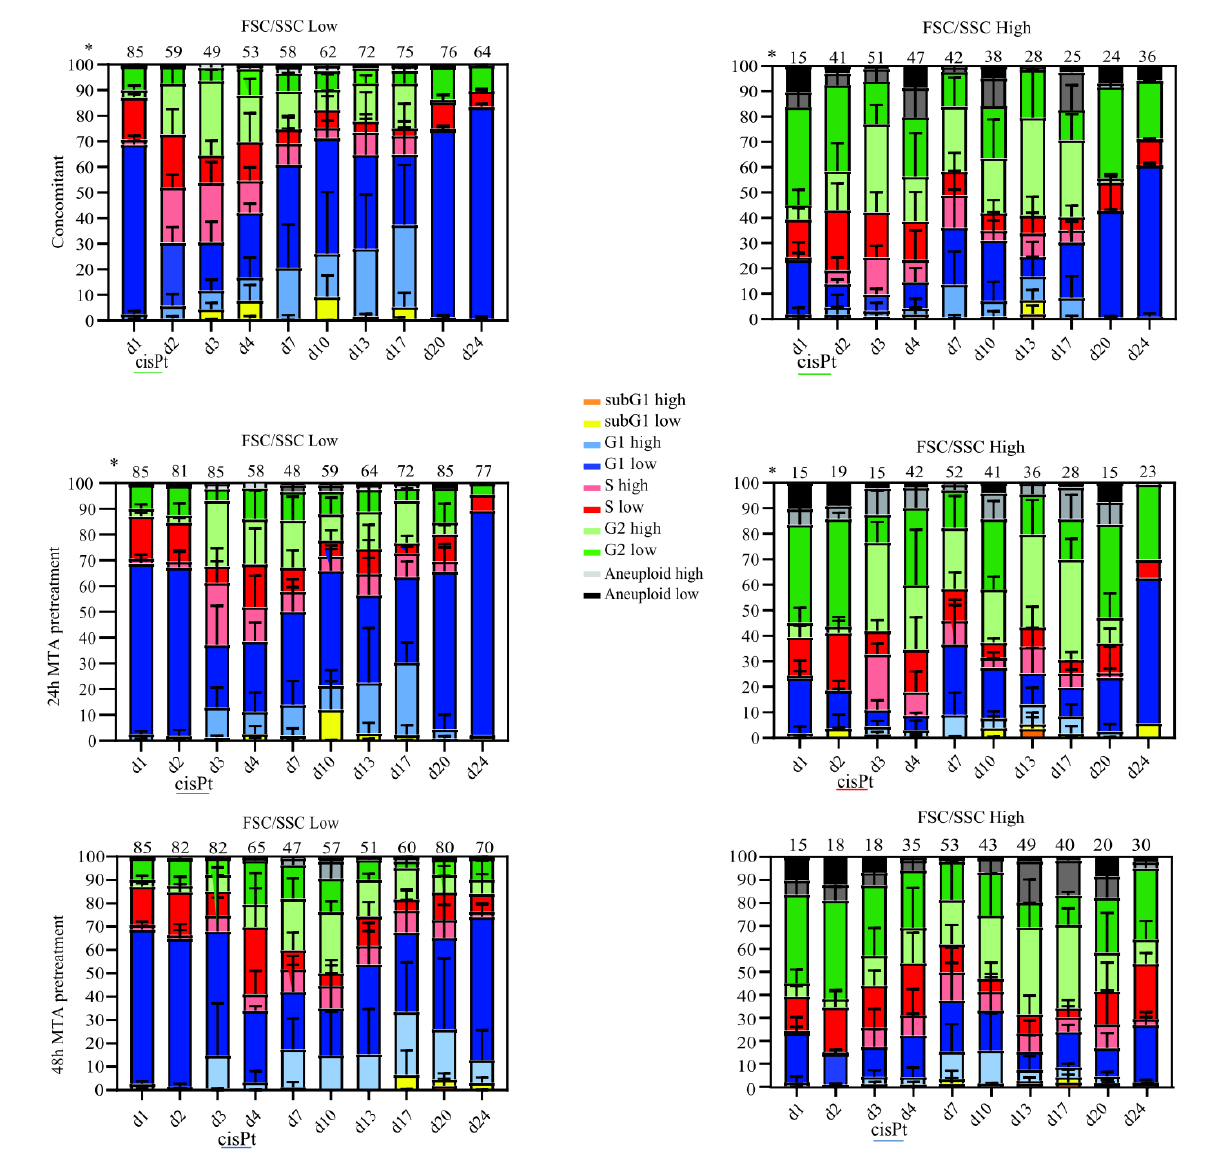
Figure 5. The cell cycle arrest induced by prolonged MTA pretreatment is associated with the accu- mulation of persistent DNA damage. Basal H2AX phosphorylation level was set at 10% in untreated control and further used for normalization during the experiment as described in the material and methods section. Cell cycle phase-specific H2AX phosphorylation levels were determined by combin- ing the subpopulation–specific γ H2AX and cell cycle gates, respectively (Figure S2B). Data shown are the mean values and standard deviations of three independent experiments. * Percentage of the total cell population (mean from three experiments). Low = γ H2AX negative, high = γ H2AX positive.